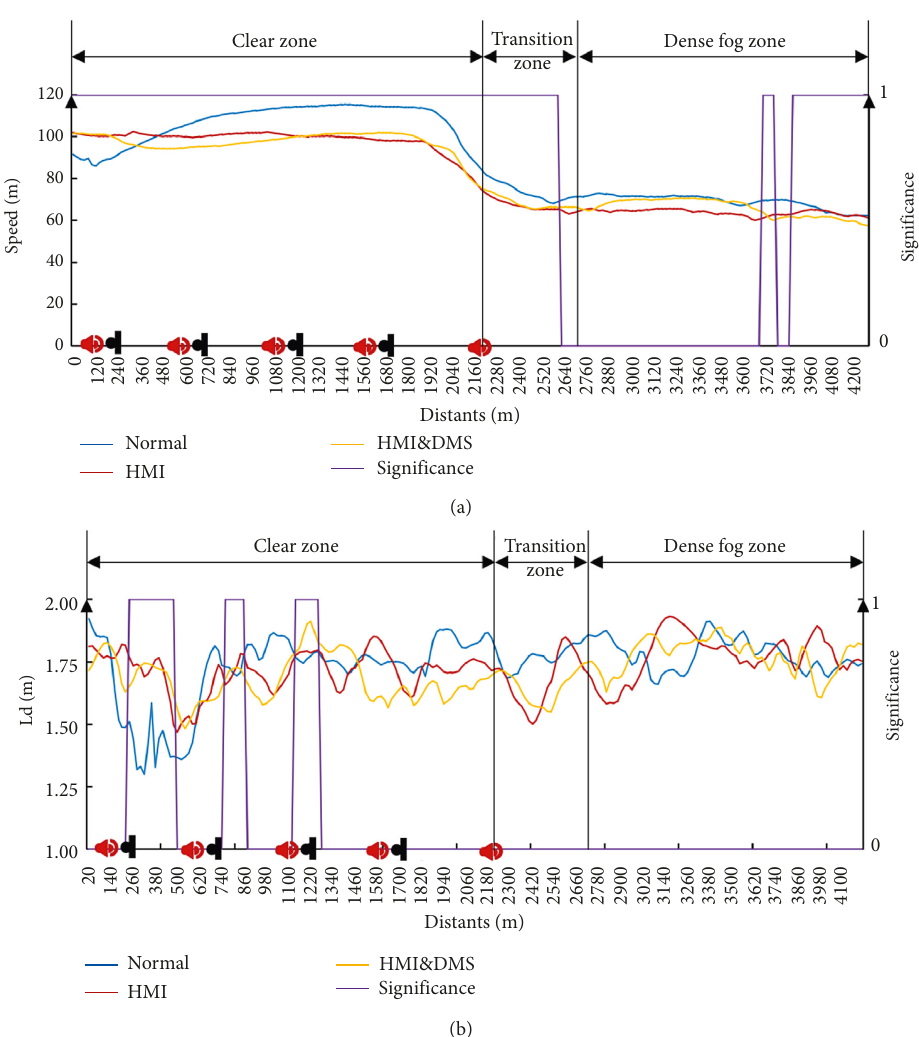
Figure 5: The changing trend of indicators. (a) Speed (significance: 1, yes; 0, no). (b) Lateral deviation (significance: 1, yes; 0,